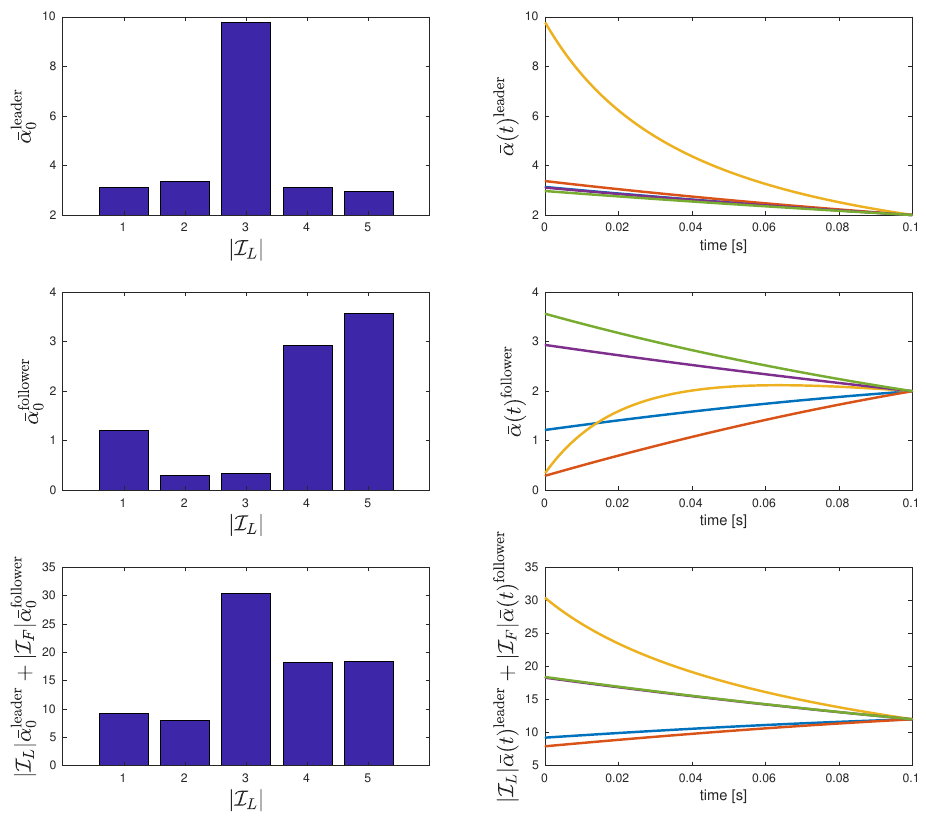
Figure 5. Evolution of the differential equations ˙¯ α leader/follower , and the corresponding initial values for the different number of leaders in the homogeneous